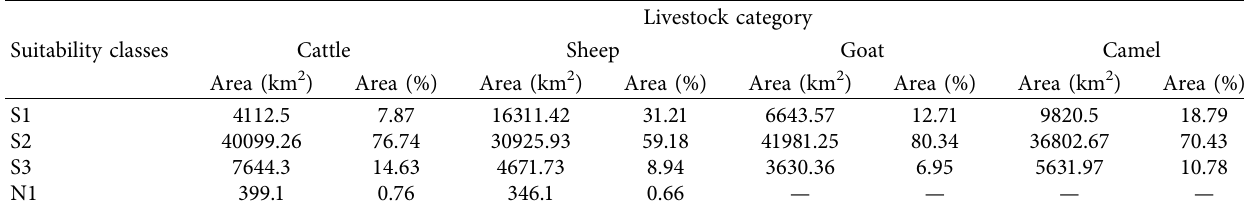
Table 4: Rangeland suitability class for livestock with respective area